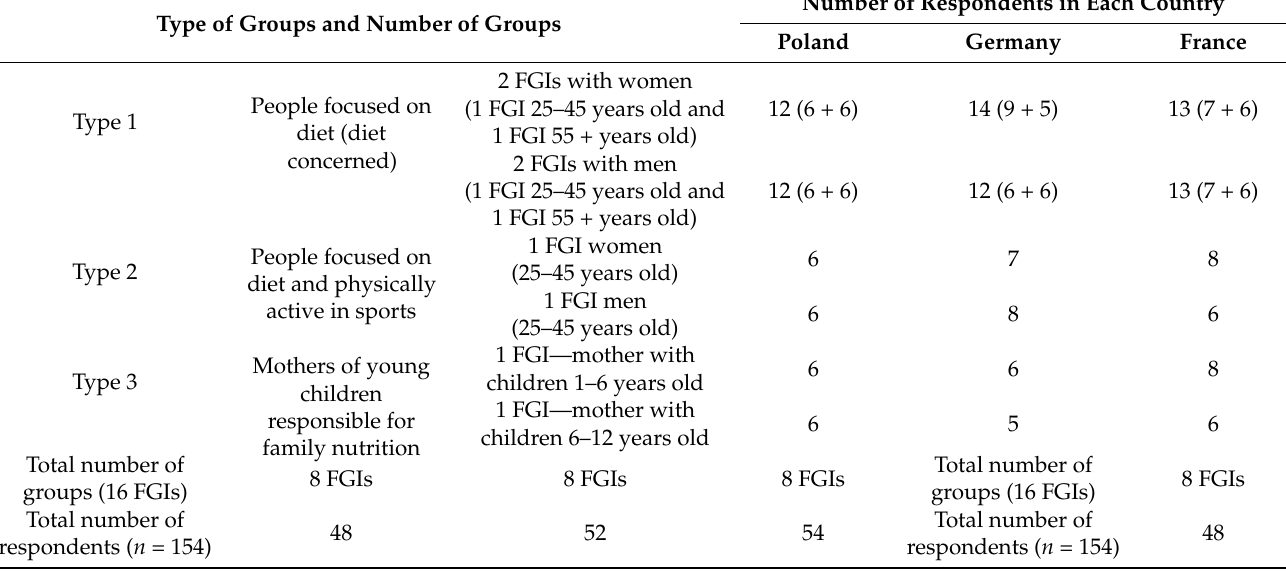
Table 1. Type of groups and number of FGIs and